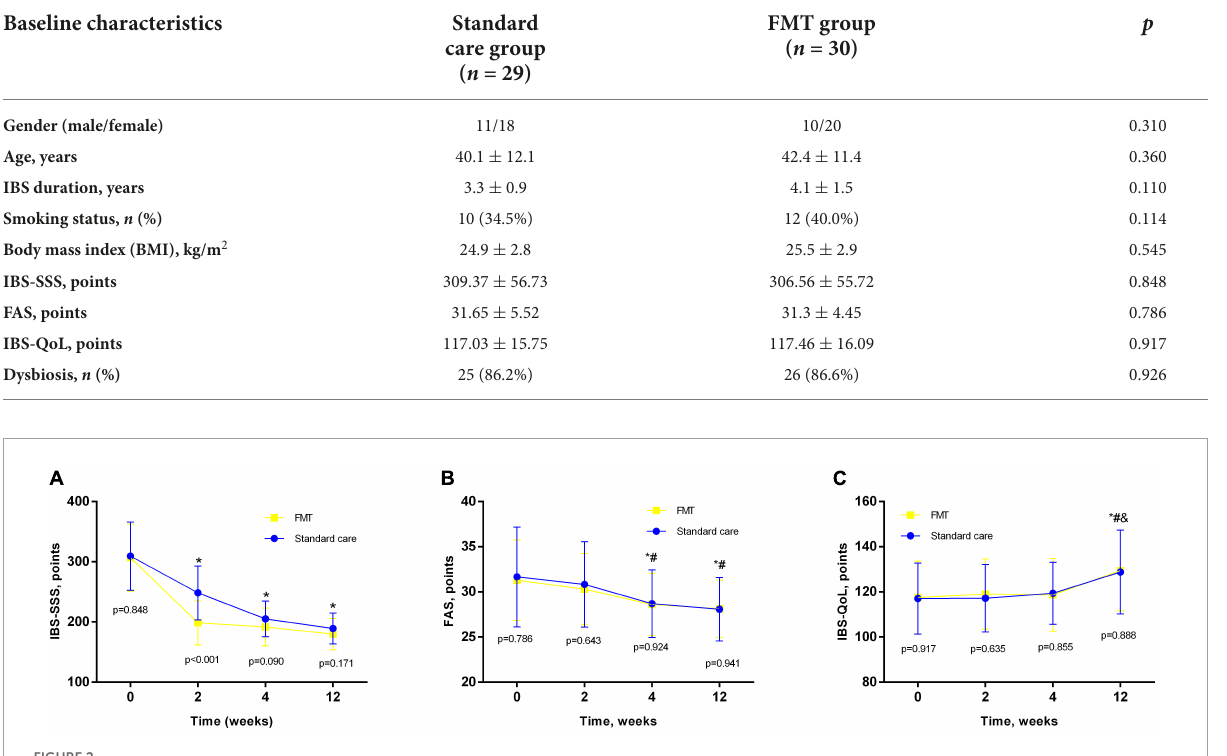
TABLE 2 Baseline clinical parameters in examined patients (M ± SD or %).